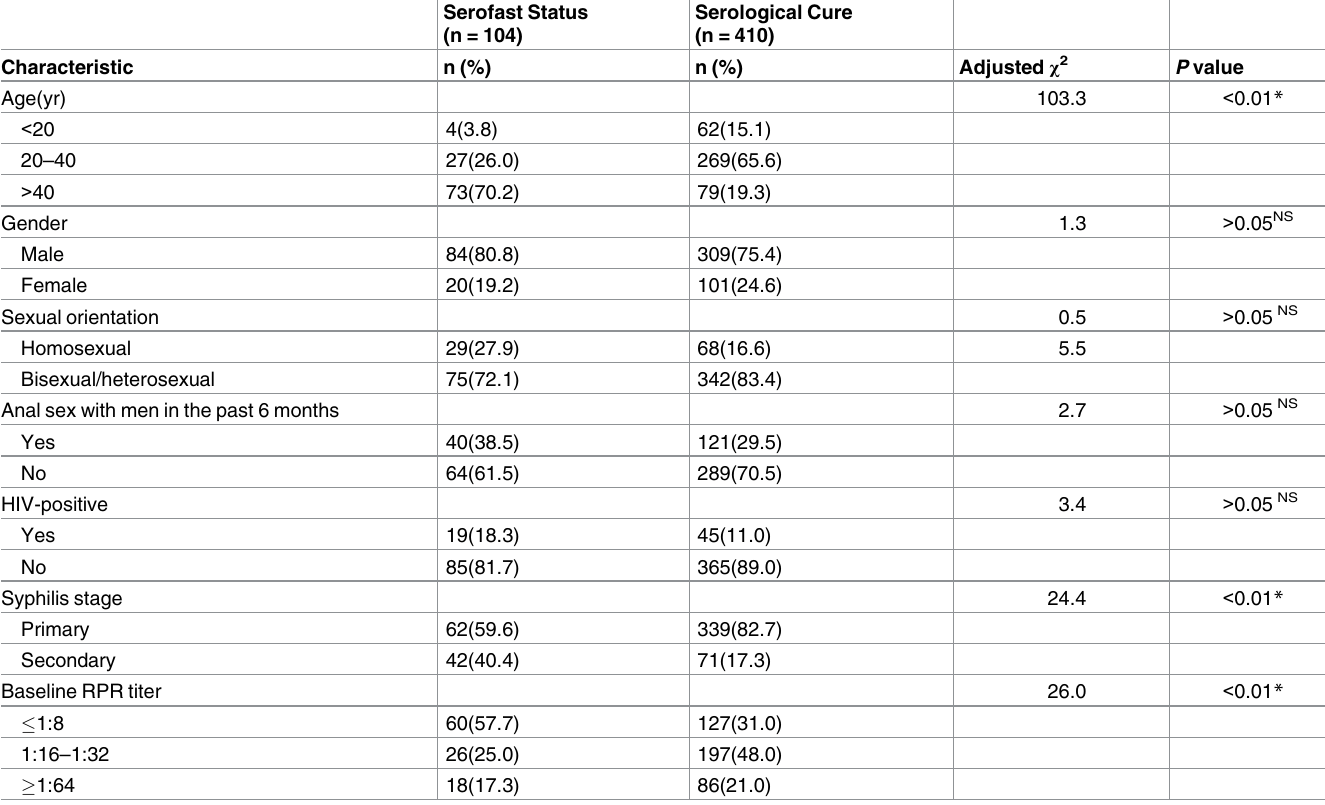
Table 2. Comparison of characteristics between serological cure and